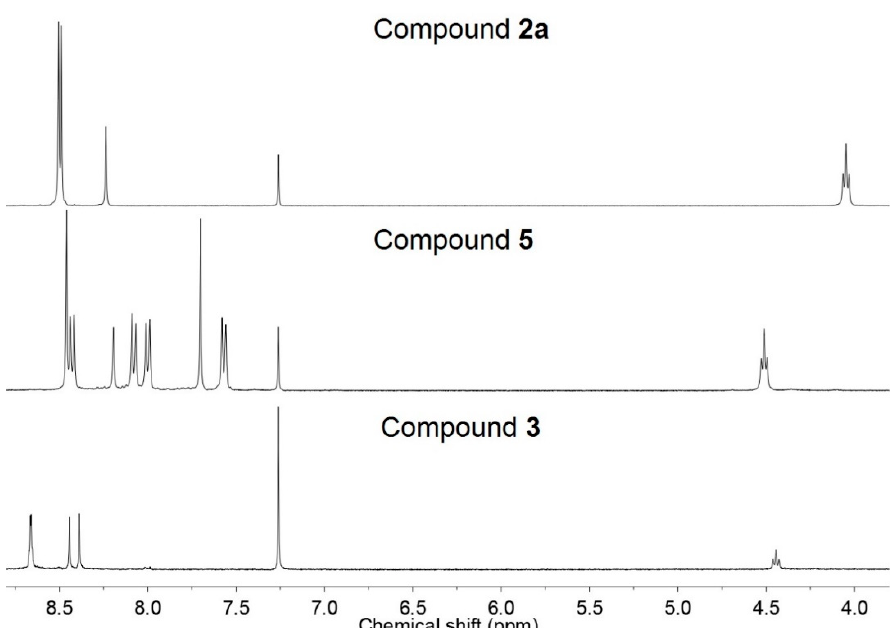
Figure 3. Partial 1 H nuclear magnetic resonance (NMR) spectra (3.8–8.8 ppm) of chromophores 3 , 5 , and 2a in CDCl 3 at 303 K. Int. J. Mol. Sci. 2020 , 21 , x FOR PEER REVIEW